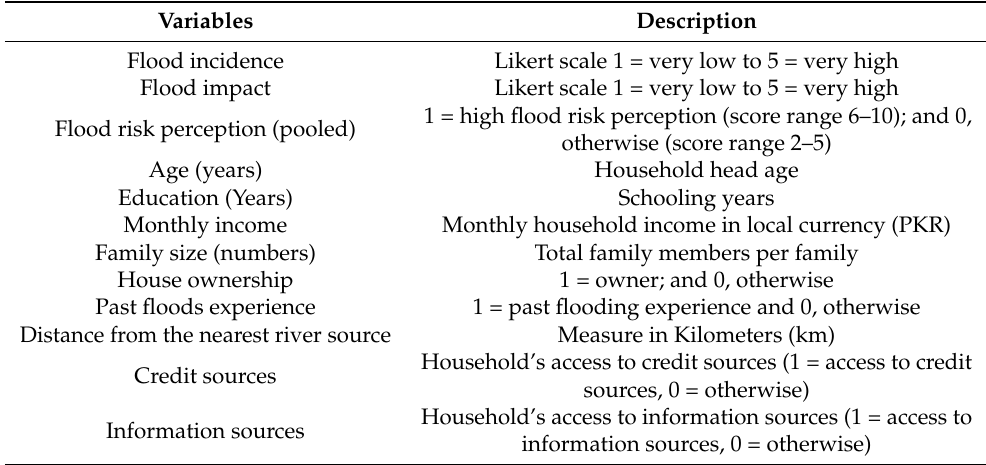
Table 1. Variables and their description.